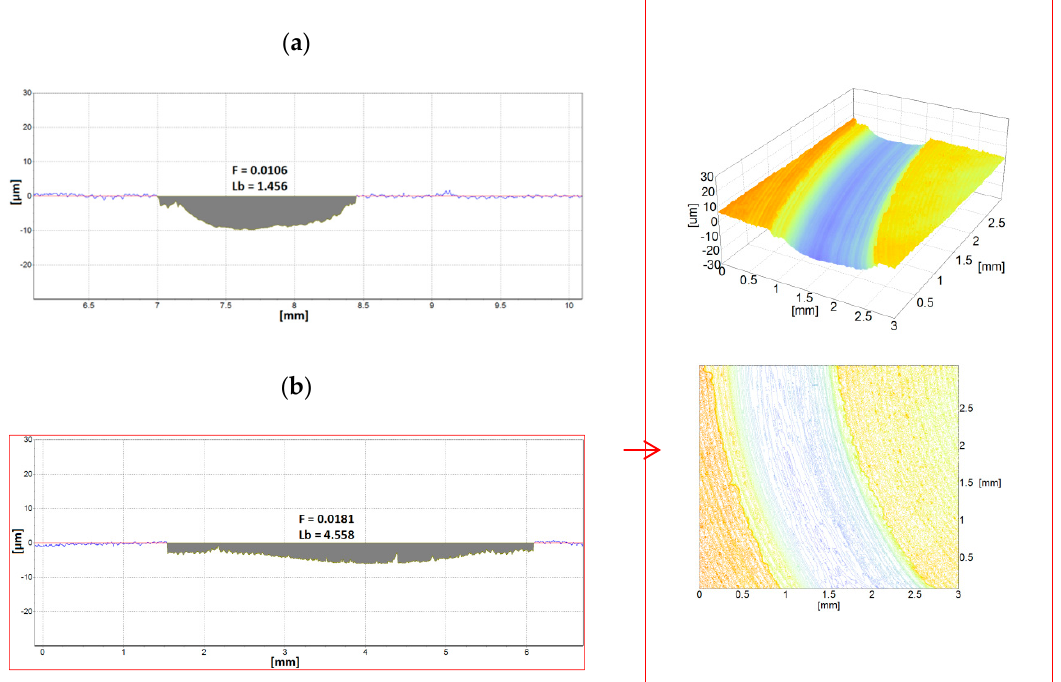
Figure 11. Profiles of wear traces created on Vanadis 8 steel samples (T-B130-SN variant) after tribologicals test using two types of counterbodies: ( a ) Al 2 O 3 ; ( b ) 19MnB4; an example of 3D view was added.